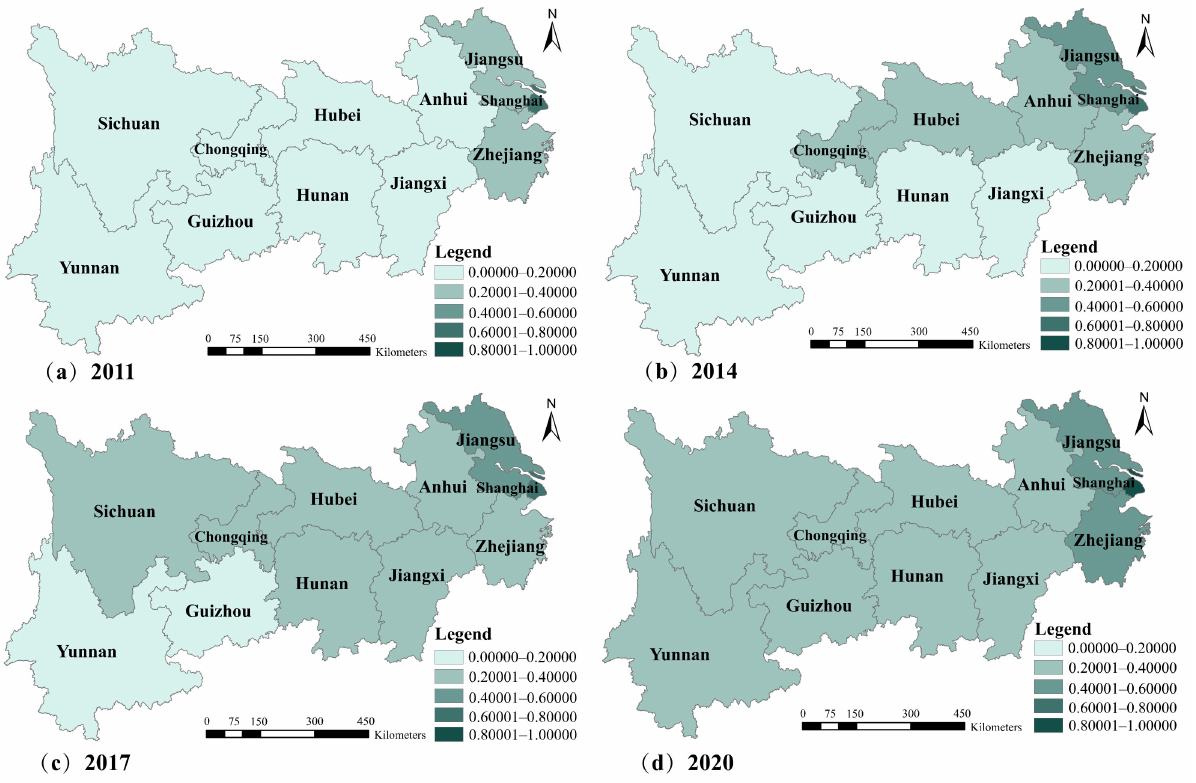
Figure 3. The spatial evolution pattern of the N-TU in the YREB, 2011–2010. Source: Authors’ drawing using ArcGIS10.7